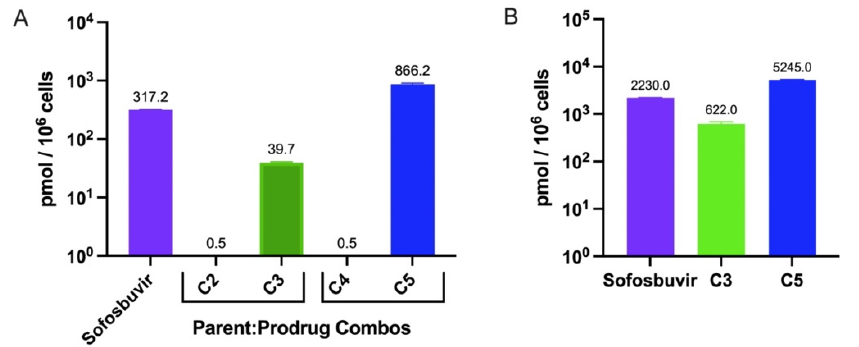
Figure 2. Intracellular metabolism of compounds into active NTP form . Huh-7 cells ( A ) or primary human hepatocytes ( B ) were plated at 10 6 cells/well and treated with 50 µ M of indicated compound for 4 hr then cells were washed and collected for analysis via LC-MS for NTP formation. Data were analyzed by GraphPad Prism v9. Data shown as mean ± SEM, n = 3.